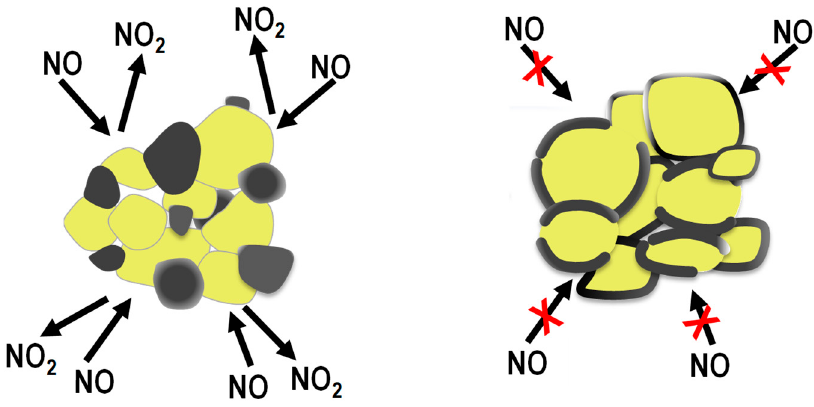
Figure 6. Scheme of NO x interaction over CZ(t) and CZ(l) (left) and CZ(m) (right). Ceria–zirconia particles are indicated in yellow, while carbon agglomerates and carbon layers are indicated in black.